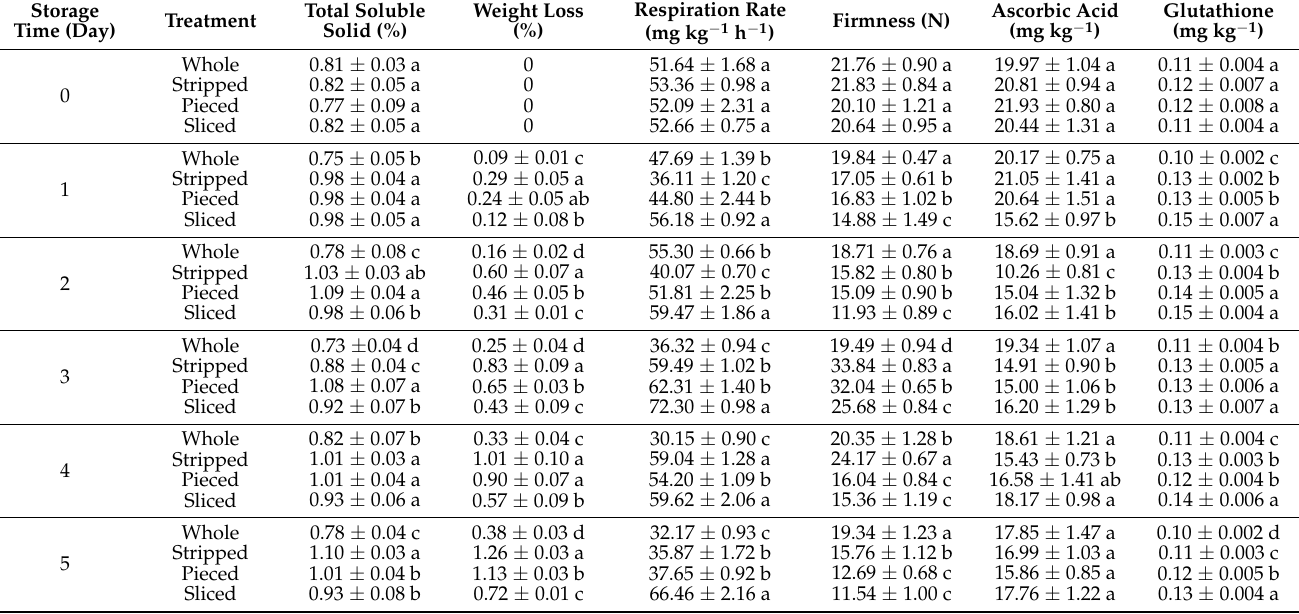
Table 1. The effect of different cutting styles on the quality of fresh-cut cucumbers stored at 4 °C.